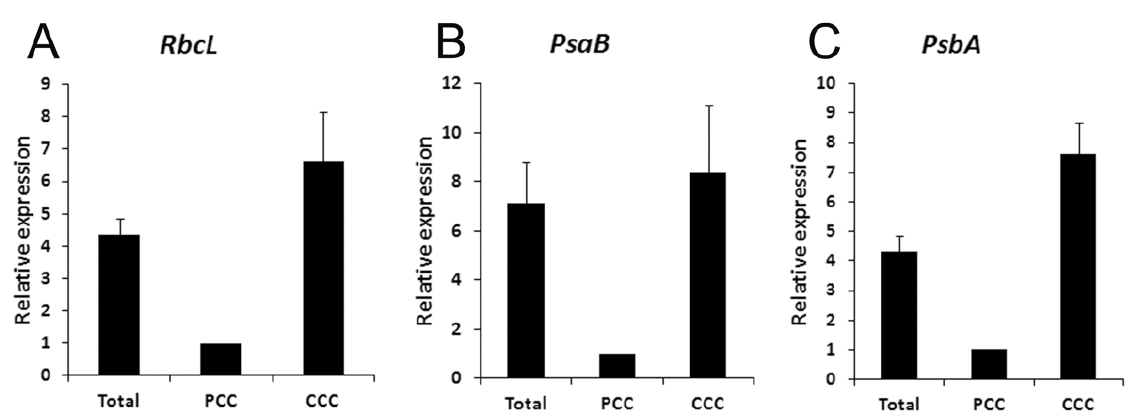
Figure 7. Real-time qPCR relative quantification of chloroplastic transcripts in two types of chloro- plasts in mature leaves of B. sinuspersici . Chloroplastic RNAs isolated from purified total, PCC, or CCC chloroplasts were used as a template and PCR amplified using gene-specific primers for ( A ) rbcL , ( B ) psaB , and ( C ) psbA as described in Methods. The means of the results from duplicates of eight independent RNA templates are shown. Each result was normalized with threshold cycle (Ct) values of 16S rRNA. Error bars indicate SE. rbcL , Rubisco large subunit; PCC, peripheral cytoplasmic compartment; CCC, central cytoplasmic compartment.